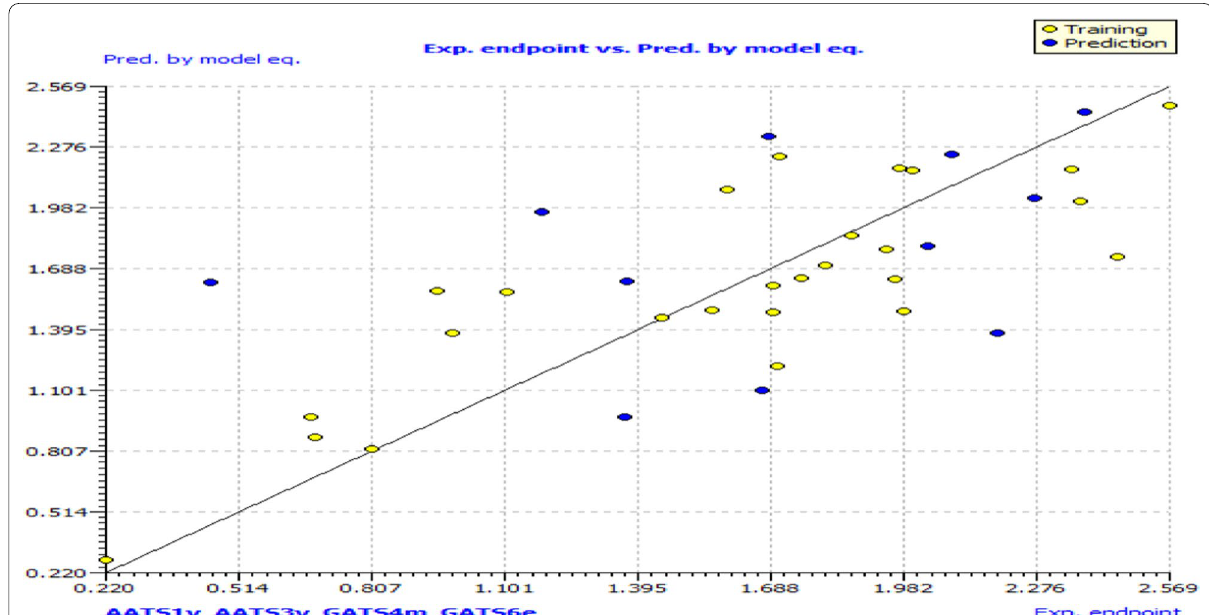
Fig. 3 Experimental endpoint values against predicted by leave one out